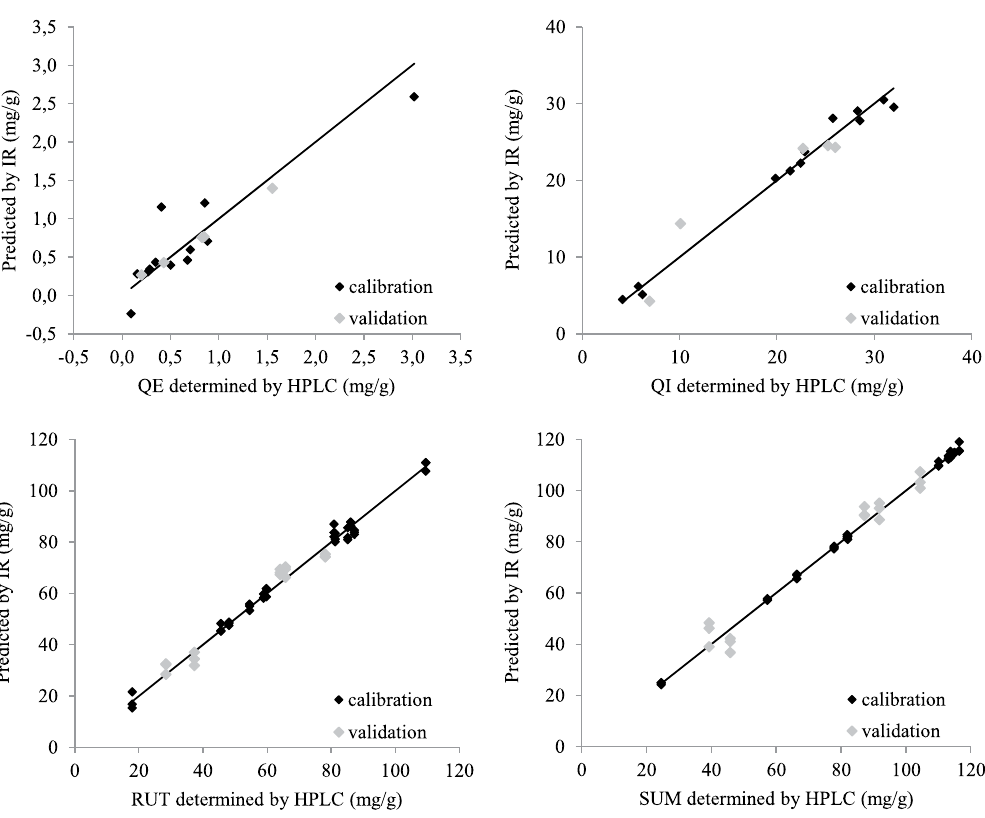
Figure 1. Concentrations of calibration and validation samples predicted by the best obtained models; quercetin (QE), quercitrin (QI), rutin (RUT) and the sum of flavonoids